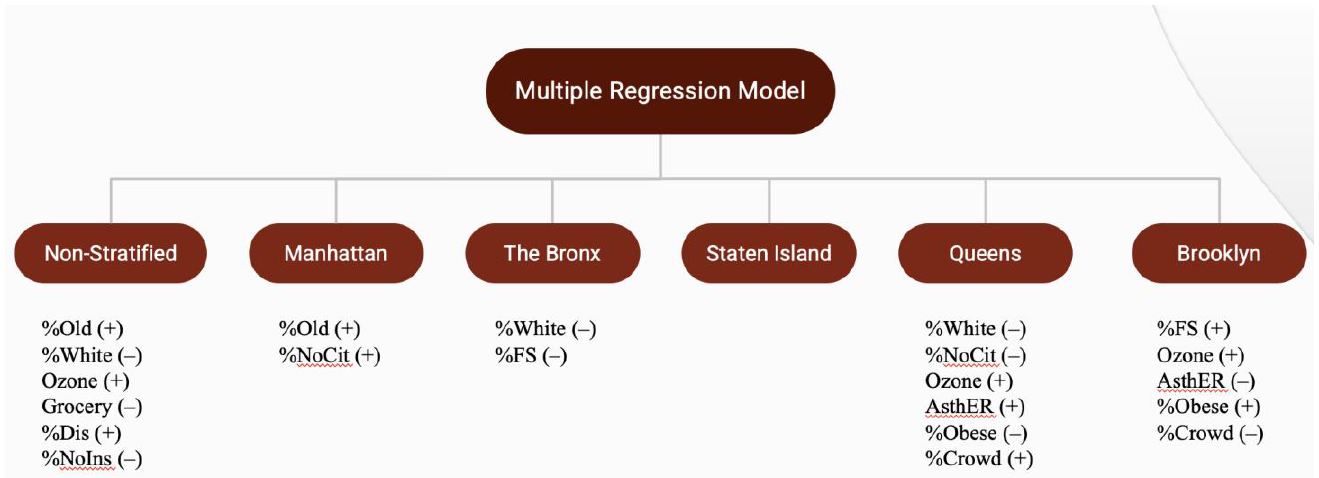
Figure 4. Summary of multiple regression of New York City COVID-19 case rate. The overall model was significant, with a p -value less than 0.001. Approximately 65.65% of the variability in the model is explained by the factors included. Significant pre- dictors of NYC COVID-19 case rate include percent 65+, percent White, ozone level, num- ber of grocery stores, percent Disability, and percent without health insurance. For Manhattan, approximately 67.84% of the variability in the model is explained by the factors included, and the model was significant ( p < 0.001). Percent 65+ and percent non-US citizen were statistically significant variables in predicting the COVID-19 case rate of this borough. In the Staten Island model, none of the individual explanatory variables were signif- icant. The model overall was significant ( p = 0.0682), and approximately 72.09% of the var- iability in the model is explained by the factors included.